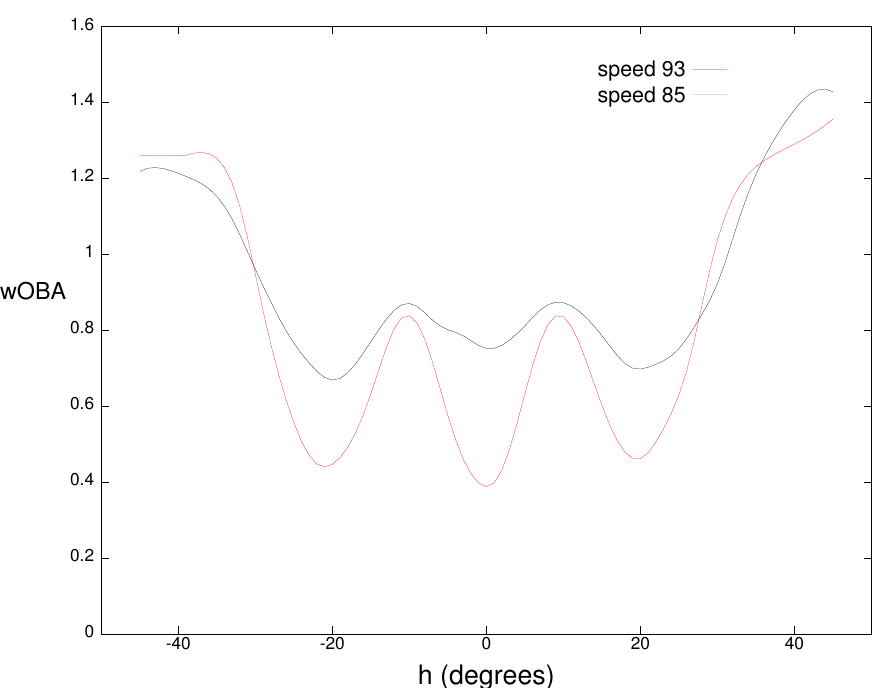
Figure 4. Weighted on base average (wOBA) for a batted ball with a vertical angle v of 16 ◦ for speed s of 85 miles per hour and 93 miles per hour.